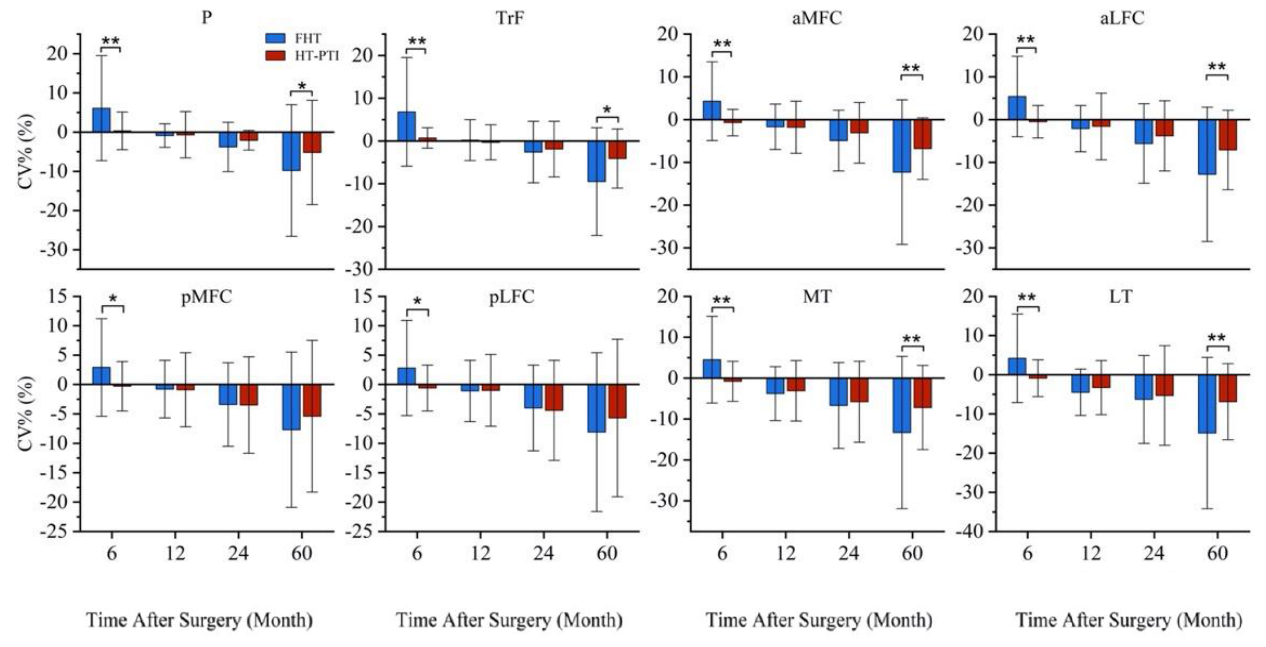
Figure 8. The CV% of cartilage between FHT group and HT-PTI group were compared. At 6 months after operation, significant differences were observed in all subgroups; Significant differences were observed in P, TrF, aMFC, aLFC, MT and LT at 60 months between two groups after operation. * p < 0.05; ** p < 0.001. CV%, the percent of cartilage volume changing; FHT, free hamstring tendon; HT-PTI, hamstring tendon with intact tibial insertion; P, patella; TrF, femoral trochlea; aLFC, anterior area of lateral femoral condyle; pLFC, posterior area of lateral femoral condyle; aMFC, anterior area of medial femoral condyle; pMFC, posterior area of medial femoral condyle; LT, lateral tibia plateau; MT; medial tibia plateau.